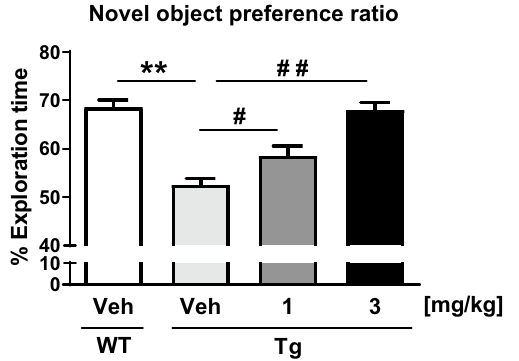
Figure 8. Restoration of impaired novel object recognition in P301S tau Tg mice by T-518. The novel object recognition test was conducted after 2 weeks of vehicle or T-518 administration (1 and 3 mg/kg). Novel object recognition performance is expressed as a preference ratio. Data are expressed as mean ± SEM and analyzed statistically as follows: Student’s t test (** p < 0.01, WT-Veh vs. Tg-Veh) or two-tailed Williams test ( # p < 0.05 and ## p < 0.01, Veh vs. 1 and 3 mg/kg in Tg), n = 14 or